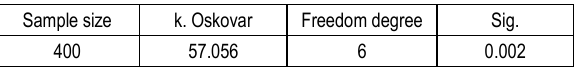
Table 12. Results of Friedman test (accountability